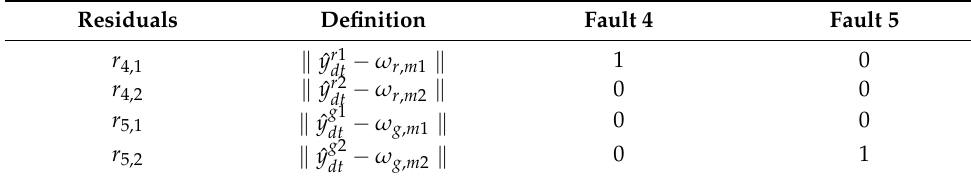
Table 2. Drive train system FDI